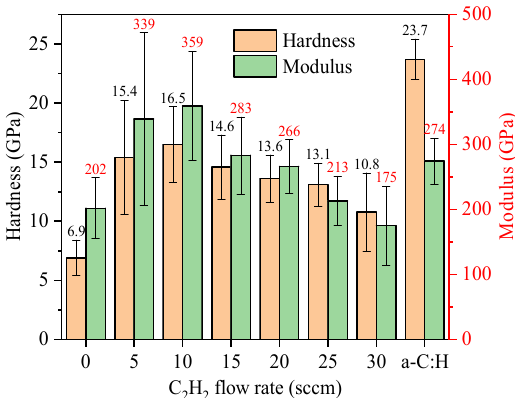
Figure 7. SEM images of CrC ( a , b ) and CrC/a-C:H ( c , d ) coatings deposited on Si substrate deposited at 0 ( a , c ) and 30 ( b , d ) sccm C 2 H 2 flow rates.